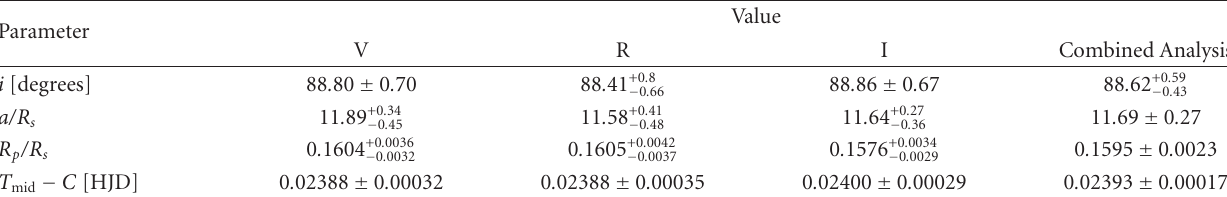
Table 4: TAP MCMC analysis of WASP-10b.